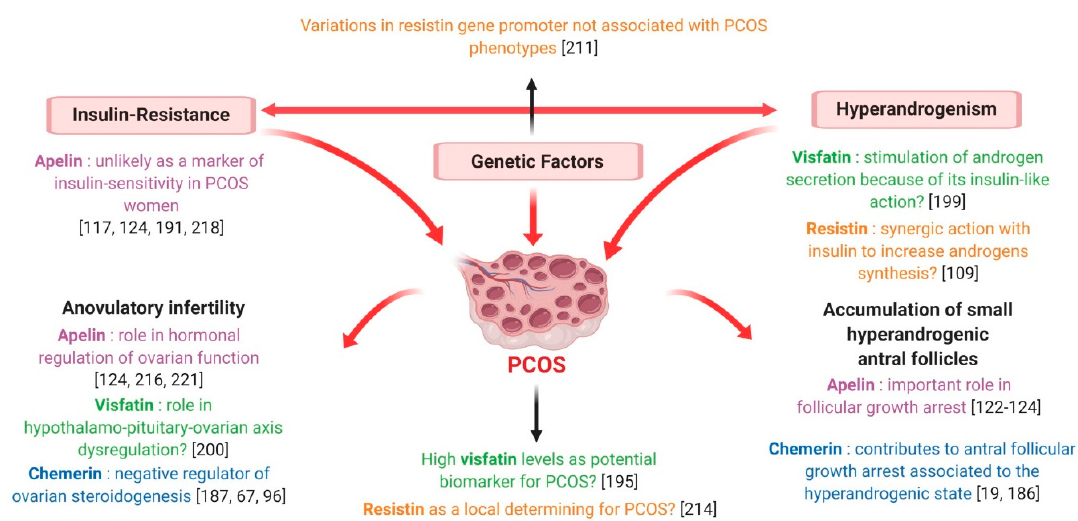
Increase / stimulation. Figure 6. Expression and effects on GnRH (Gonadotropin-Releasing Hormone) release of chemerin,